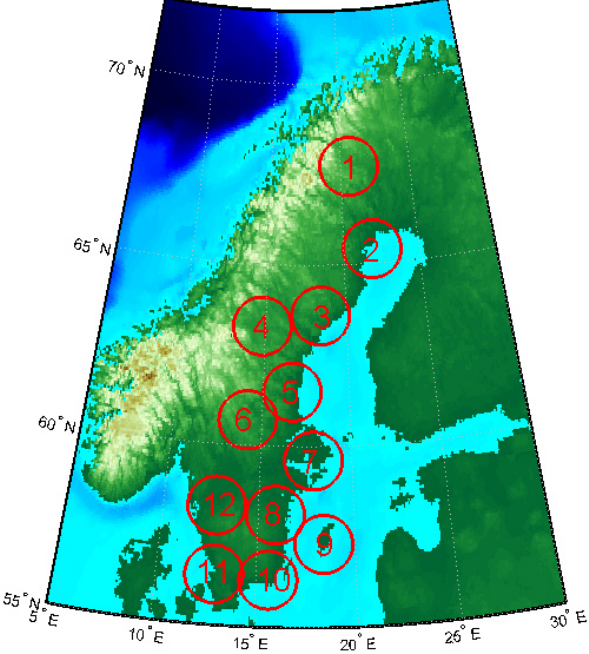
Figure 1. Geographical position of the 12 radars in Sweden. The areas enclosed by circles are used for